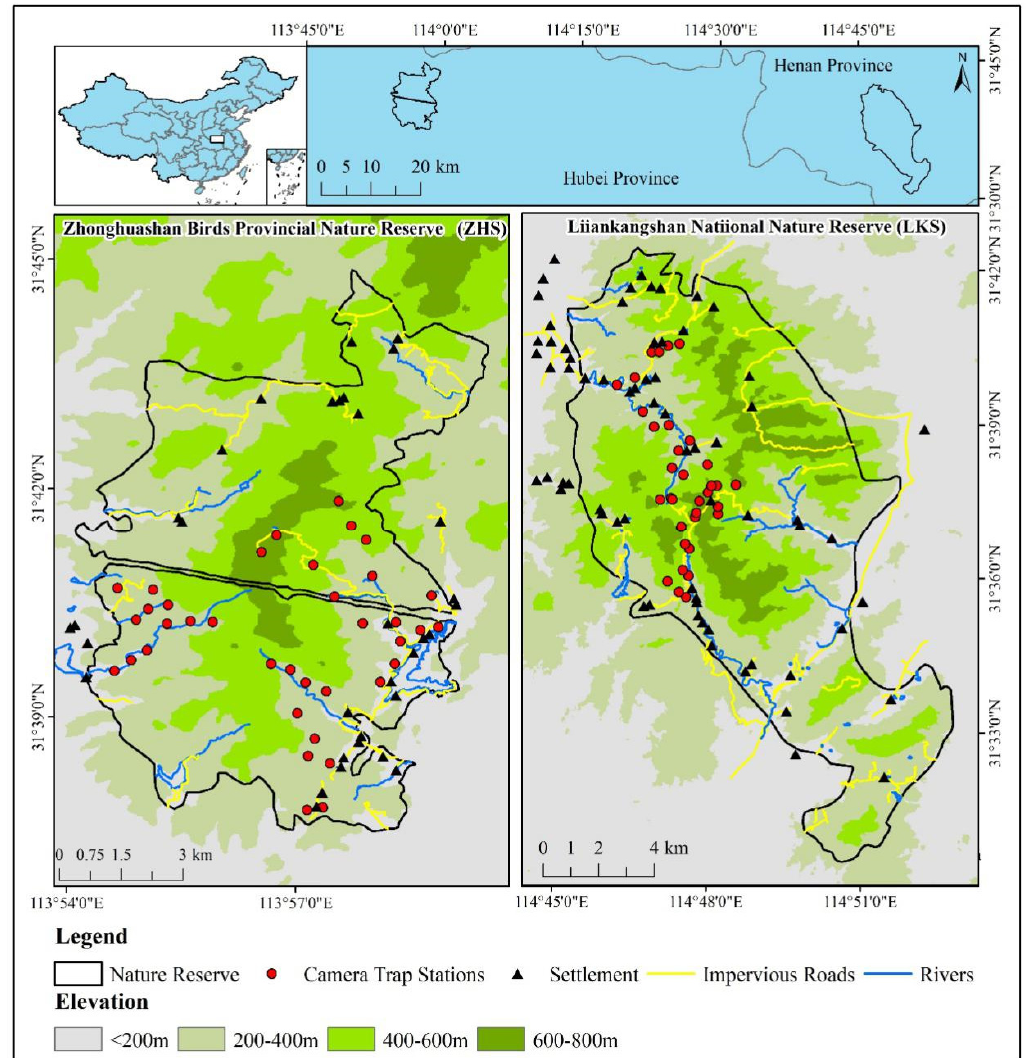
Figure 1. Camera trap stations in LKS and ZHS, inset showing the locations of the study areas in China.